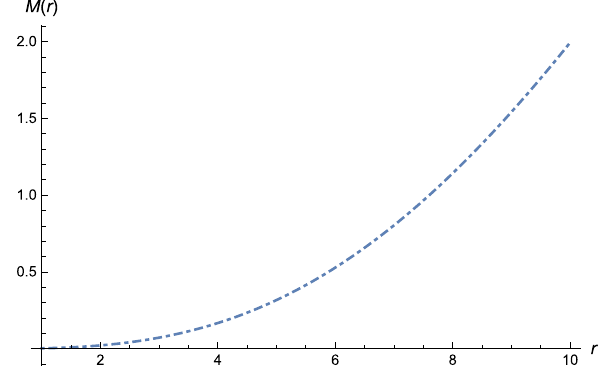
Fig. 11 Evolution of the mass function M ( r ) for the strange star can- didate Her X-1 with respect to the radial coordinate r (km) The graphical evolution of the surface redshift is given in Fig. 12. The value of the function Z S for the case of the strange star candidate Her X-1 is calculated as Z S ≈ 0 . 22, which is within the desired bound of Z S ≤ 2.